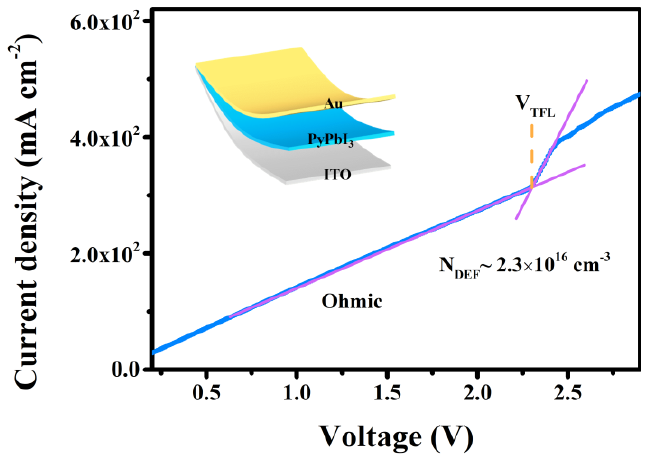
Figure 5. Current–voltage curves of the devices adopting the as-illustrated configuration. Inset: Device scheme of ITO/perovskite/Au.